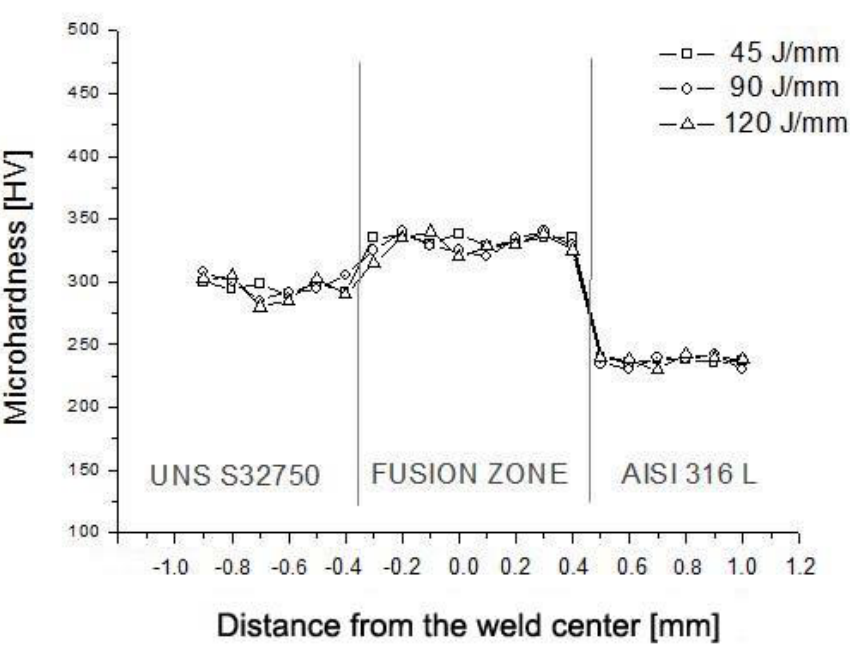
Figure 6. Microhardness profile along the dissimilar weld joints at different heat inputs.